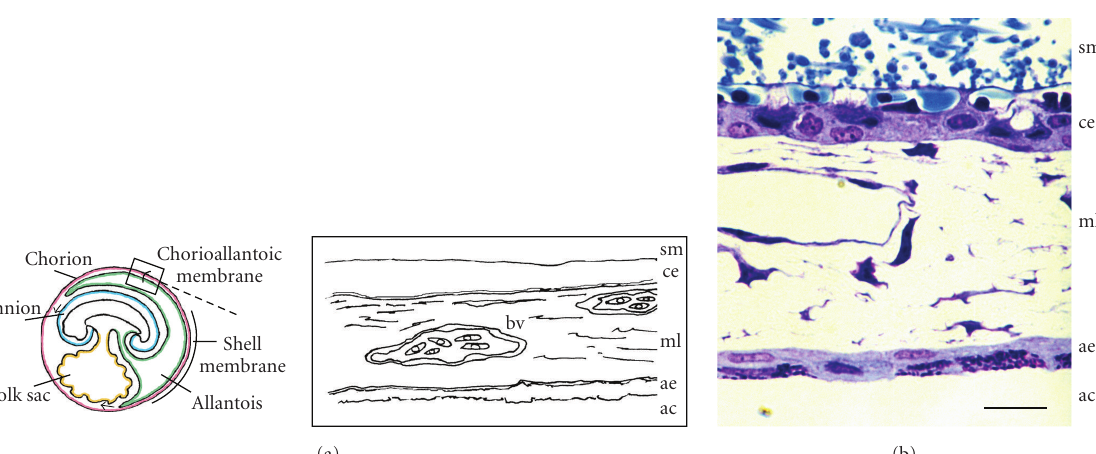
Figure 1: The three-tissue layers of the chick mature CAM are indicated in the schematic representation in (a) and clearly recognizable at day 16 of incubation, after Toluidine blue staining (b): the chorionic epithelium (ce) adheres to the shell membrane (sm); the intermediate mesodermal layer (ml) contains blood vessels; the allantoic epithelium (ae) lines the allantoic cavity (ac). (a) Modified from Gabrielli et al.